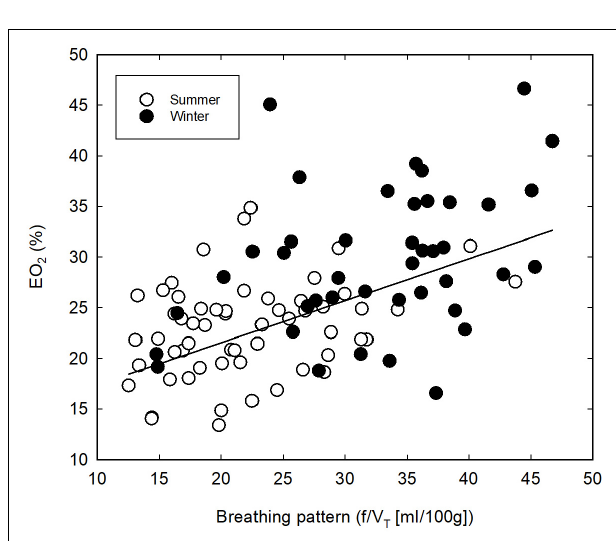
FIGURE 3 | Relationship between breathing pattern and lung oxygen extraction (EO 2 ) in summer- (open symbols) and winter-acclimatized (closed symbols) great tits. Each point shows the mean value for an individual bird at a single ambient